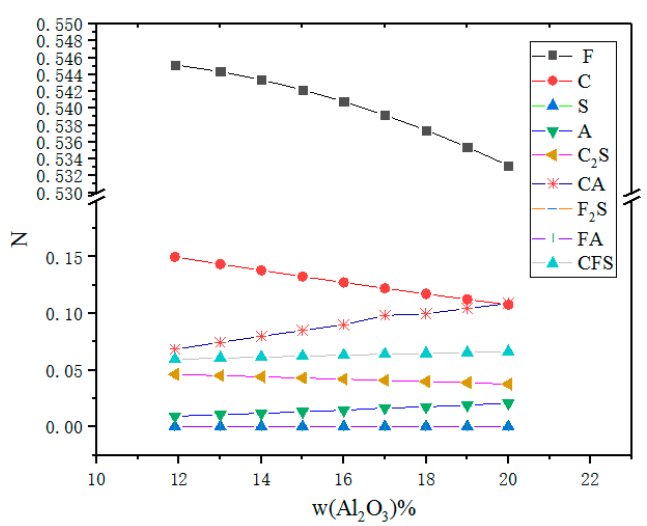
Figure 8. Activity trend of some components in slag 2, C 2 S, CA, F 2 S, FA and CFS represent 2CaO·SiO 2 , CaO·Al 2 O 3 , 2FeO·SiO 2 , FeO·Al 2 O 3 and CaO·FeO·SiO 2 , respectively.